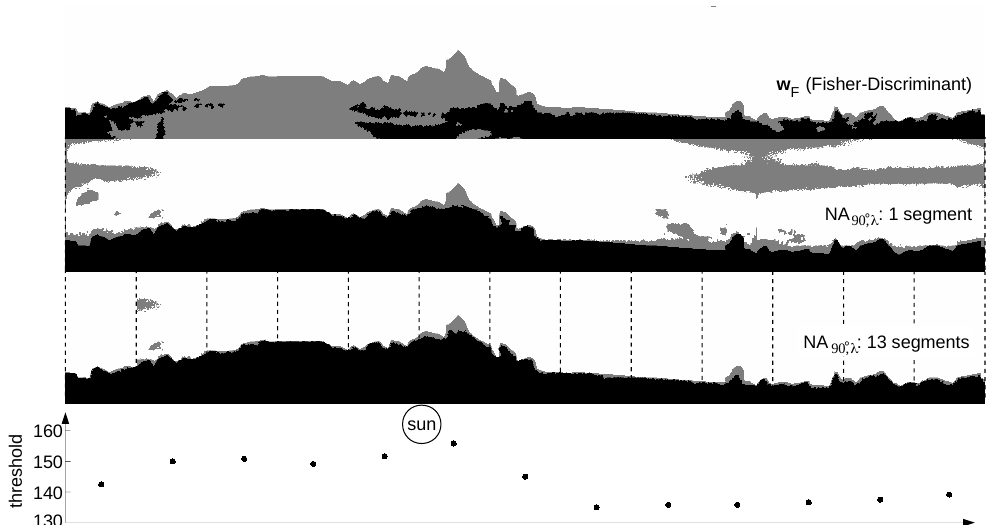
Figure 17. Example of a skyline extraction from the panoramic log UV/G image shown in Figure 16 using the separation techniques w F (global) and NA 90 ◦ , α (local, UV-only) (middle, bottom). Pixels classified as sky and ground are colored white and black, respectively, while gray pixels indicate misclassifications. The gradient of the log UV and log G data over the sky shown in Figures 15 and 16 increases the difficulty for local separation techniques to find a threshold value to separate both classes on the whole image. By splitting the panoramic image into smaller images (bottom; here 28 ◦ steps), this problem can be avoided. The graph shows the threshold values for each individual segment. Contrary to local separation techniques, global separation techniques cannot be individually adapted for single segments. The classification rates from top to bottom are 82.1%, 87.4% and 98.0%. The classification rates for in total 12 recorded panoramic images can be found in Table 3.